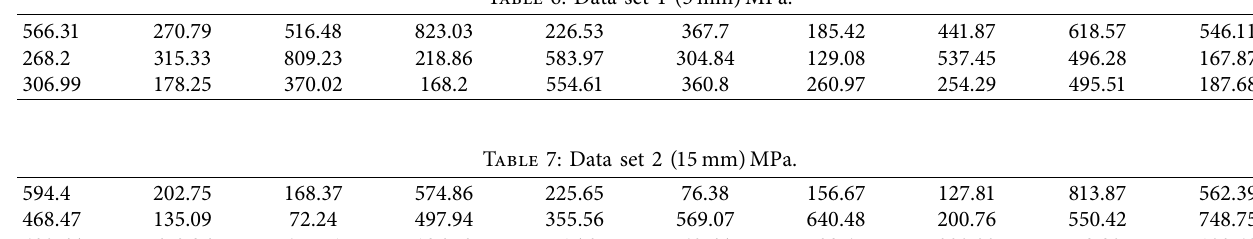
) at R � 0.556. < Y MRSS NRSS